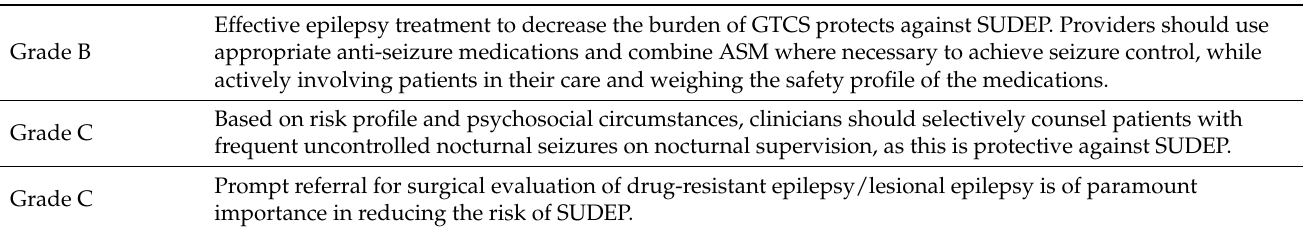
Table 2. Clinical practice recommendations for SUDEP treatment.